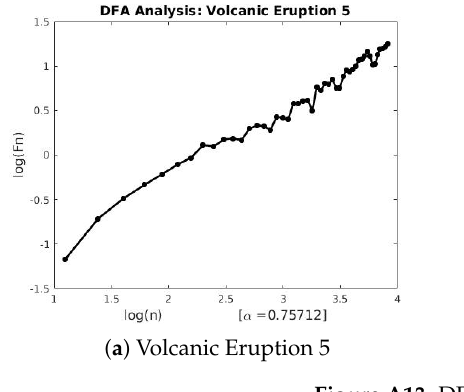
Figure A13. DFA for Volcanic Eruption 5 and 6.